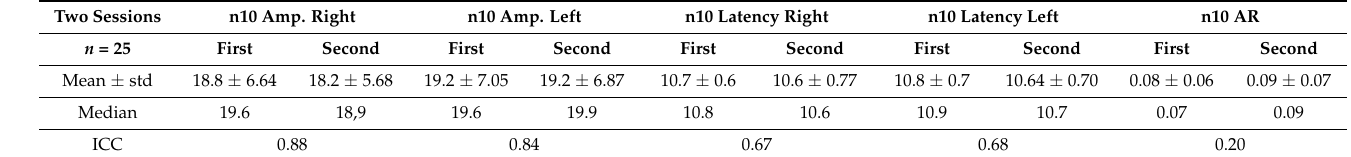
Table 3. Calculated amplitudes and latencies (side-specific) of the n10 wave and asymmetric ratio with mean ± standard derivation (std), median, and interclass correlation coefficient (ICC) depend- ing on first and second measurements in one session. Table 4. Calculated amplitudes and latencies (side-specific) of the n10 wave with median, mean ± std, and interclass correlation coefficient (ICC) depending on the first and the second measurements in two sessions. n10 Amp.